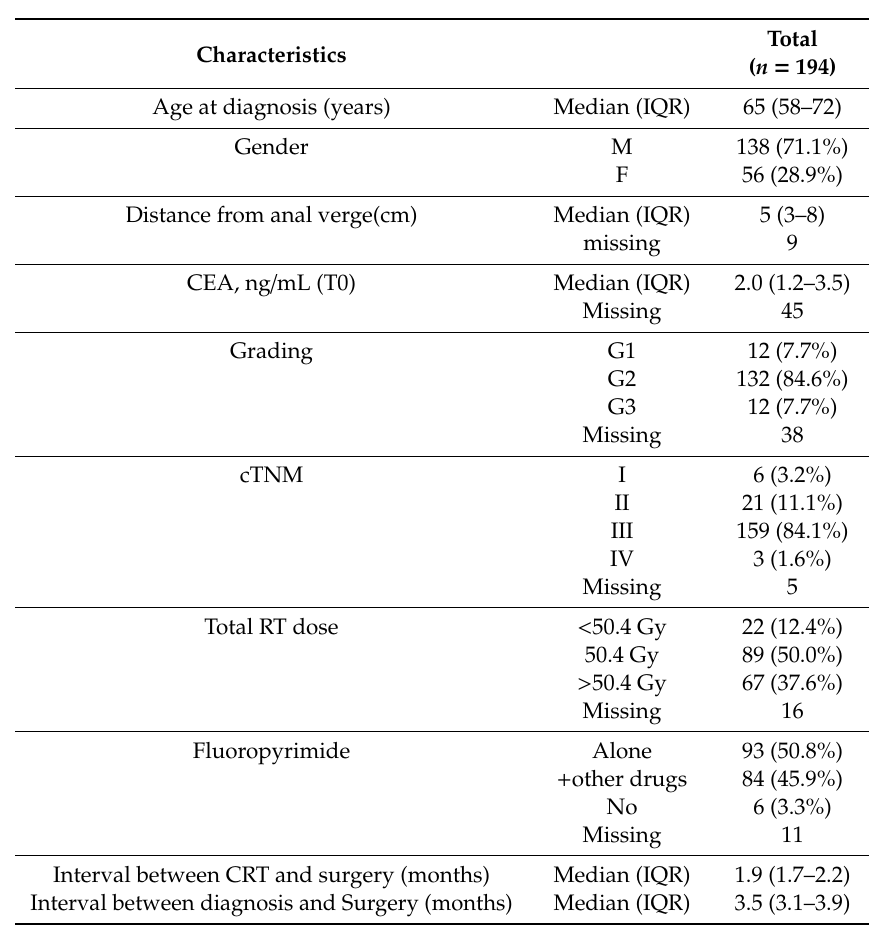
Table 1. Clinical and demographic characteristics of rectal cancer